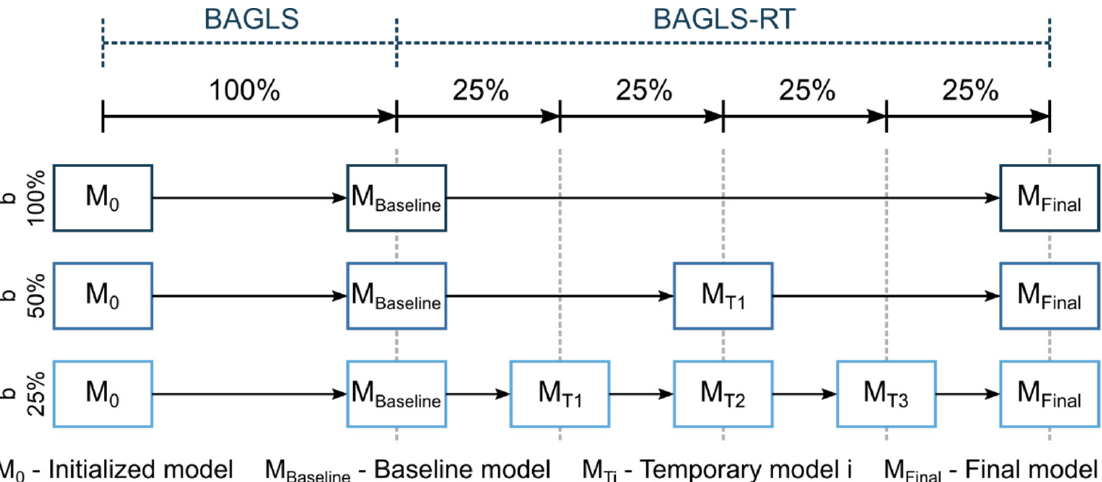
Figure 8. Illustration of the incremental finetuning process for the different batch sizes.